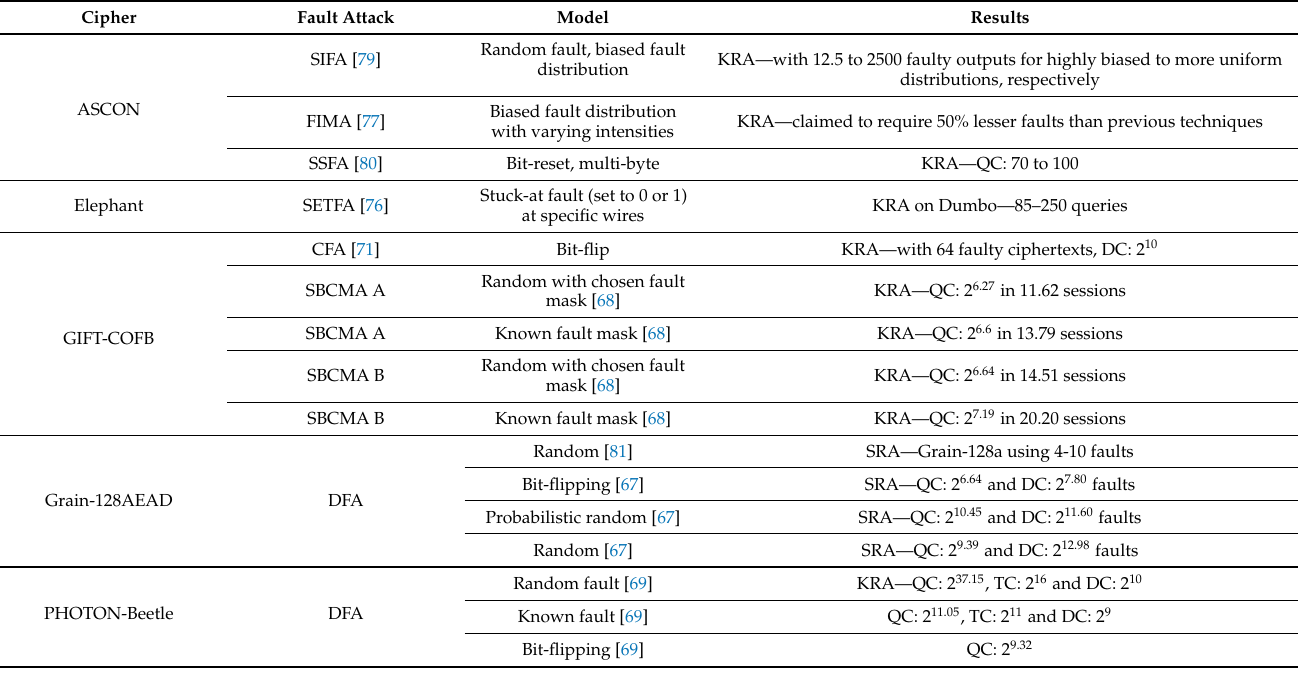
Table 3. Summary of fault analyses of the LWC